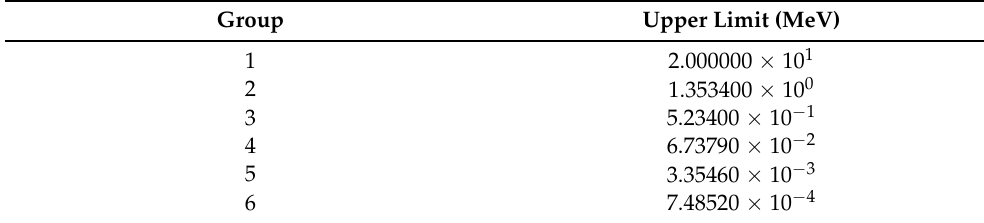
Table 2. Neutron energy groups employed.